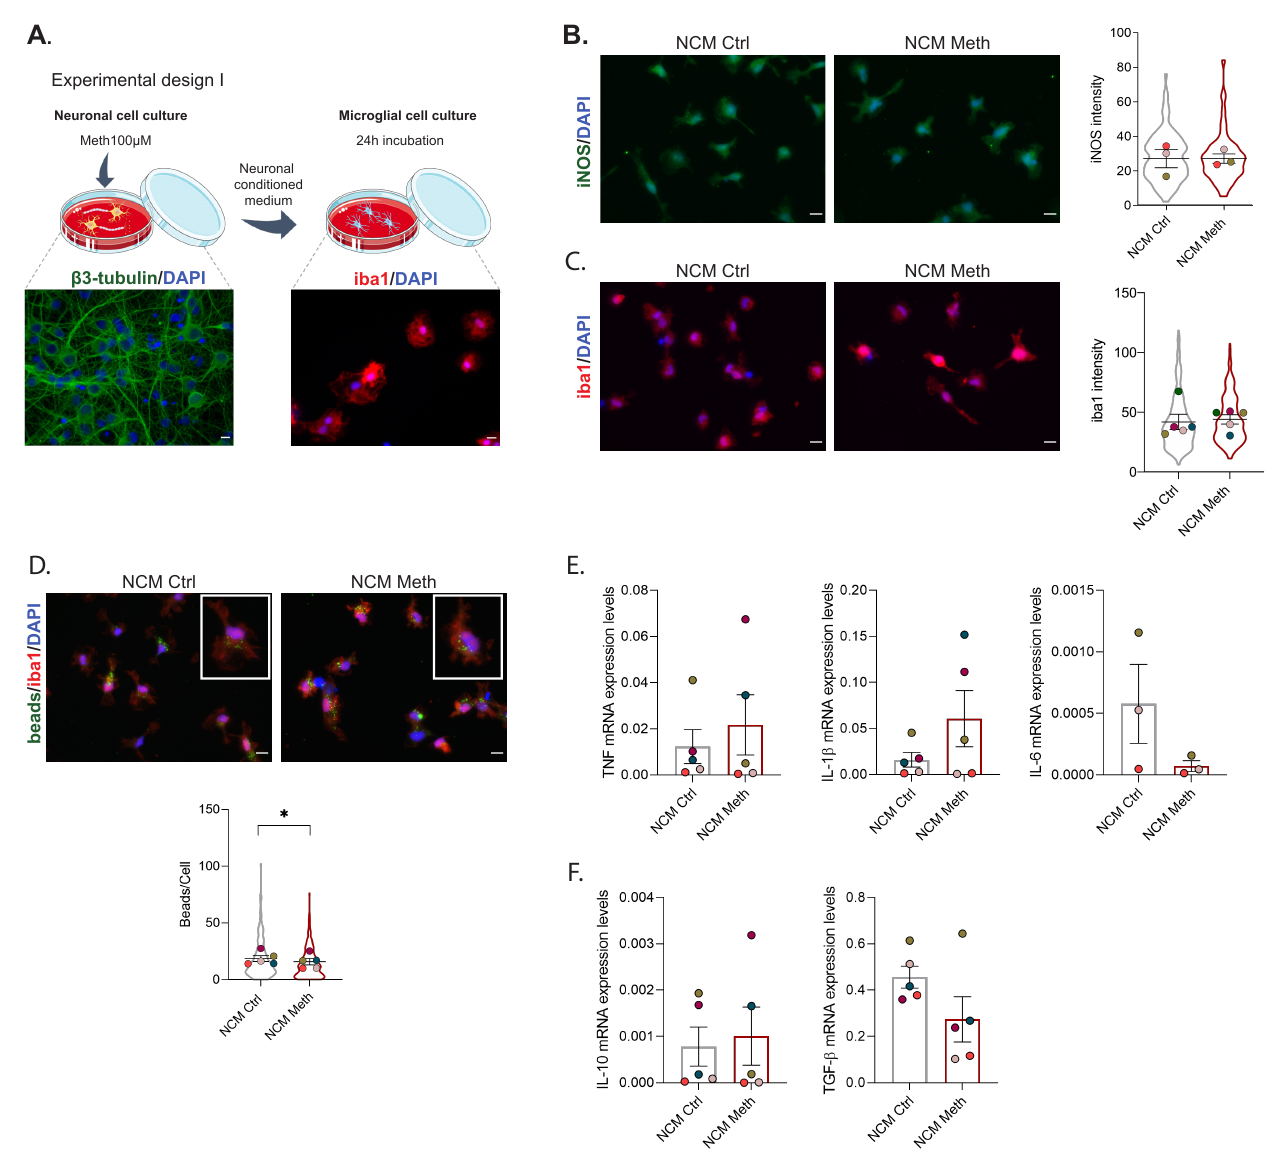
Figure 3. Neurons partially prevented microglia activation via Meth-exposed astrocytes. ( A ) Exper- imental design III—primary cell cultures of astrocytes were incubated with Meth 100 µ M for 24 h. Neuronal cells from the hippocampus were seeded in one side of a microfluidic device, and the axons were allowed to extend to the other compartment for 12 days. On DIV12, microglial cells were seeded in the axonal compartment. The conditioned media obtained from astrocytes treated with Meth (ACM Meth) or from control astrocyte cultures (ACM Ctrl) were added to the microglia/axonal compart- ment for 24 h. ( B ) Fluorescence imaging of microglial cells co-cultured with neurons and exposed to the ACM Ctrl or ACM Meth for 24 h. Microglial cells were immunolabeled for iNOS (green), and results express the iNOS intensity (mean ± SEM) of five independent cultures (ACM Ctrl—405 cells; ACM Meth—329 cells). ( C ) Fluorescence imaging of microglial cells immunolabeled for iba1 (red) incubated with NCM Ctrl or NCM Meth for 24 h. Results express iba1 intensity (mean ± SEM) of four independent cultures (Ctrl—151 cells; Meth—184 cells). ( D ) Fluorescence imaging of microglial cells co-cultured with neurons and incubated with ACM Ctrl or ACM Meth for 24 h. Microglia were incubated with microbeads (green) and immunolabeled for iba1 (red). The results represent the number of beads per cell (mean ± SEM) of five independent cultures (ACM Ctrl—183 cells; ACM Meth—248 cells). ( E ) Fluorescence imaging of microglial cells co-cultured with neurons and